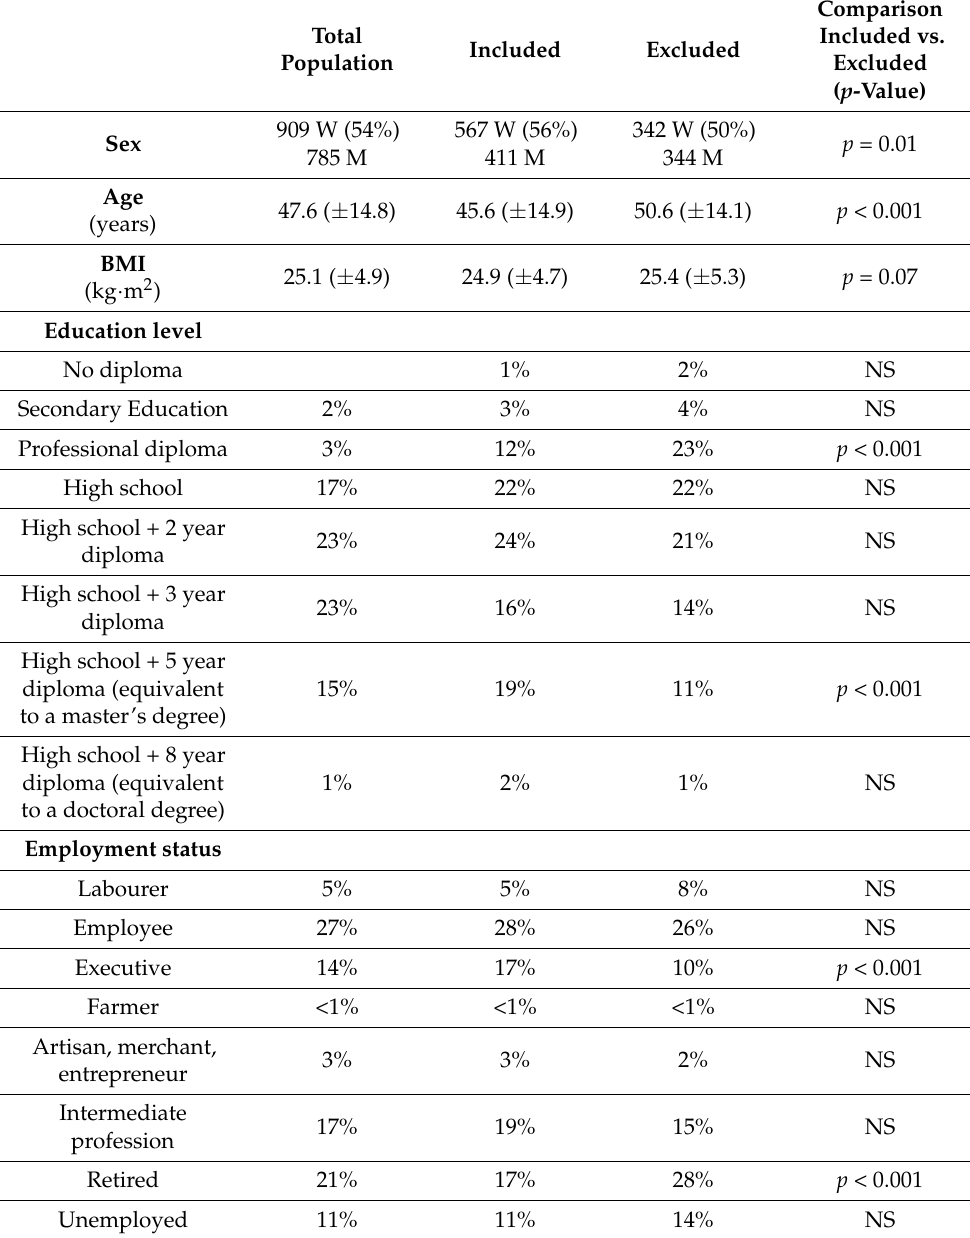
Table 3. Comparison of demographic information, education level, and employment status between included and excluded individuals.